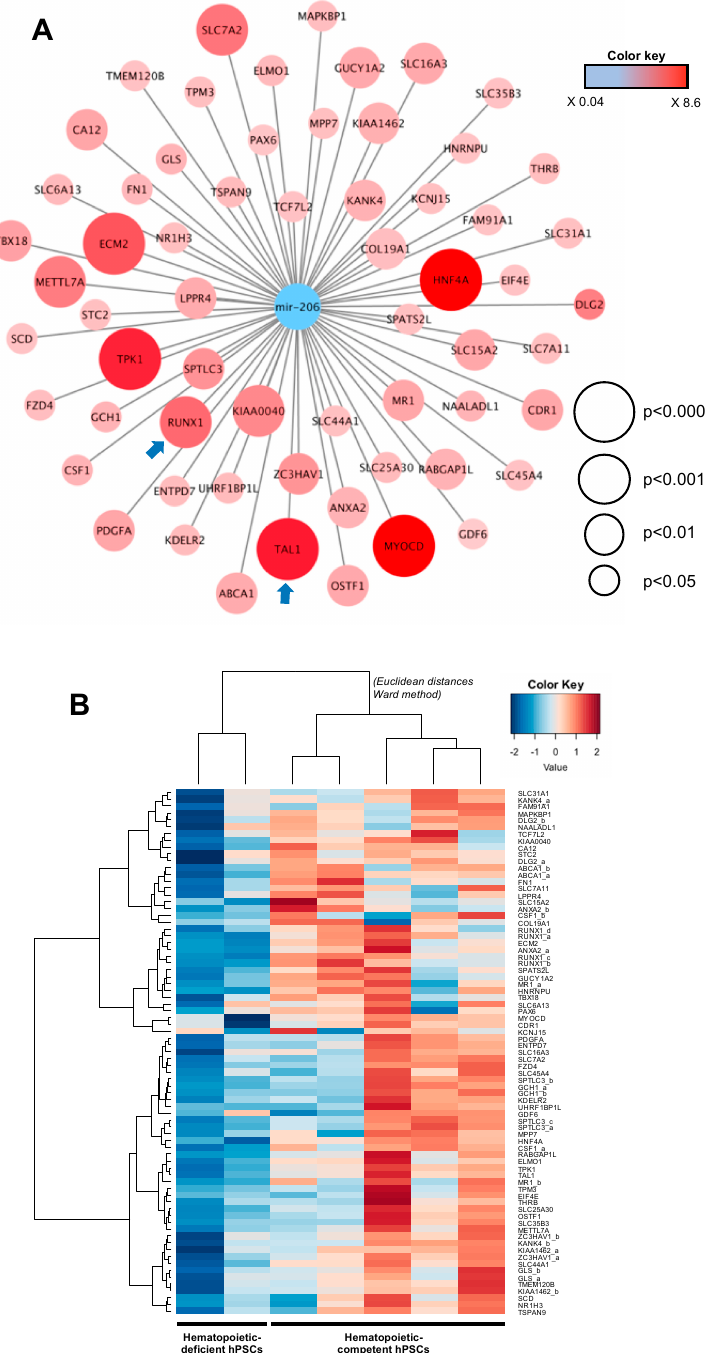
Figure 4. Integrative miRNome and transcriptome analysis. ( A ) Cytoscape representation of a predictive miR-206-regulated gene network potentially involved in the regulation of the hematopoietic differentiation of human pluripotent stem cells; ( B ) Unsupervised expression heatmap of 62 miR-206 target genes predicted in TargetScan v7.2 distinguishes EB cells according to their hematopoietic potential. Blue arrows highlight hematopoietic master regulators RUNX1 and TAL1.